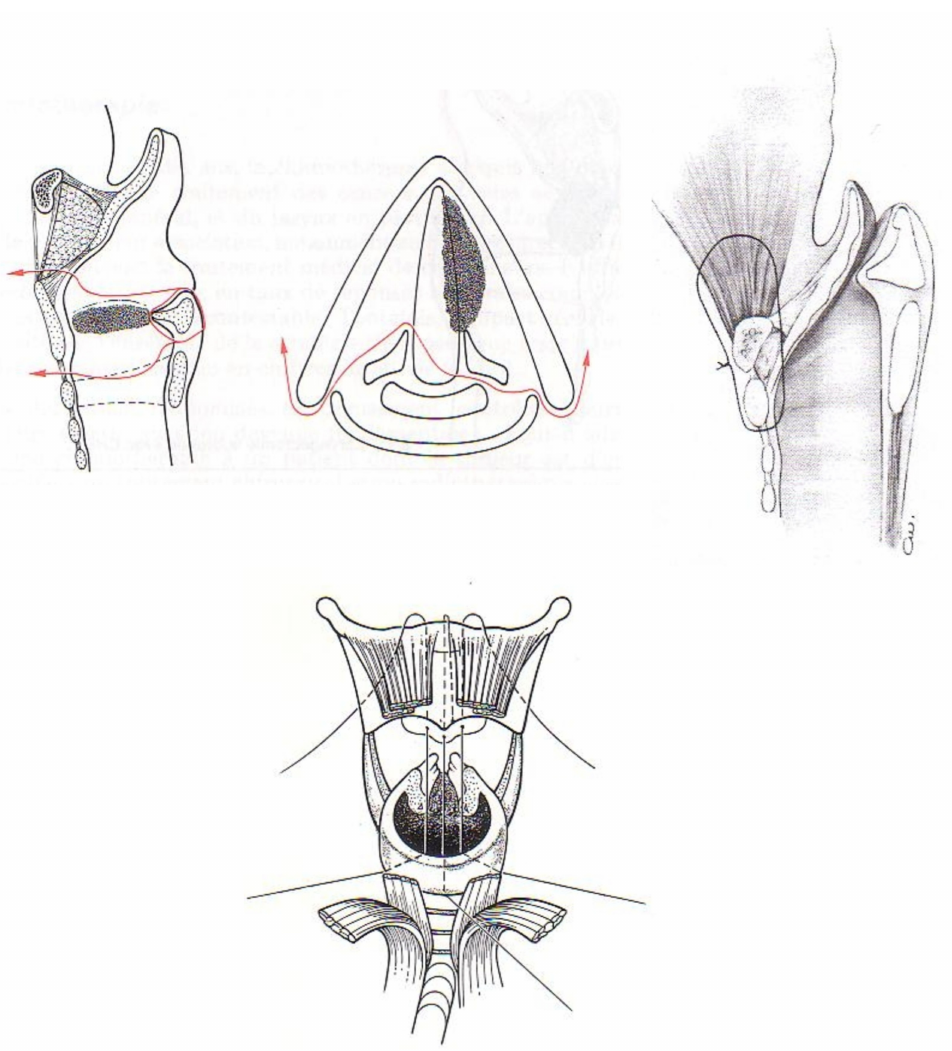
Figure 4. Supracricoid laryngectomy with crico-hyoido-epiglottopexy. Resection of the entire thyroid cartilage and both vocal folds with preservation of at least one arytenoid cartilage. Reconstruction: the closing of the larynx is carried out by an impaction between the cricoid cartilage, the epiglottis, the hyoid bone and the base of the tongue called a